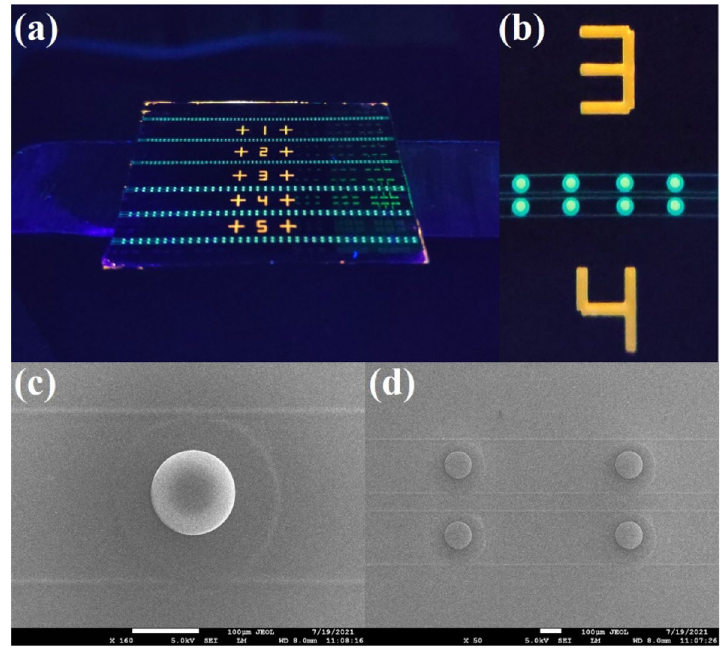
Fig. 10 a The actual fluorescence dual-microdisk stimulated by a UV point light source at 365 nm wavelength; b the images captured of white light emission for dual-microdisk chip; c and d SEM images of the dual-microdisk waveguide